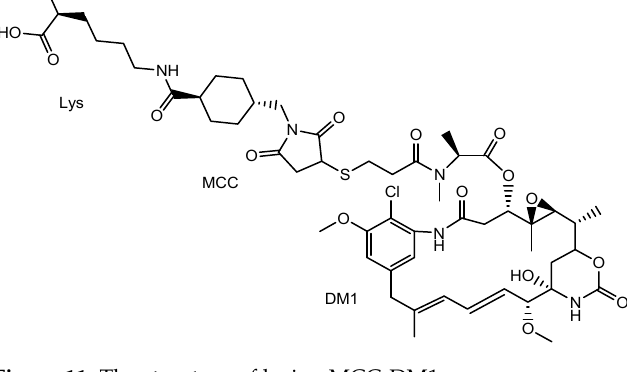
Figure 10. The structure of lysine-specific demethylase-1 (KDM1A) inhibitors such as NCL-1 and NCD-38.